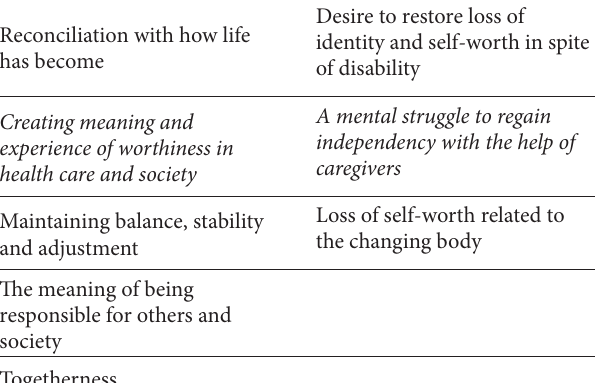
Table 2: Main themes, themes and sub-themes that emerged in the qualitative review of health and ill health among old persons and need of community health